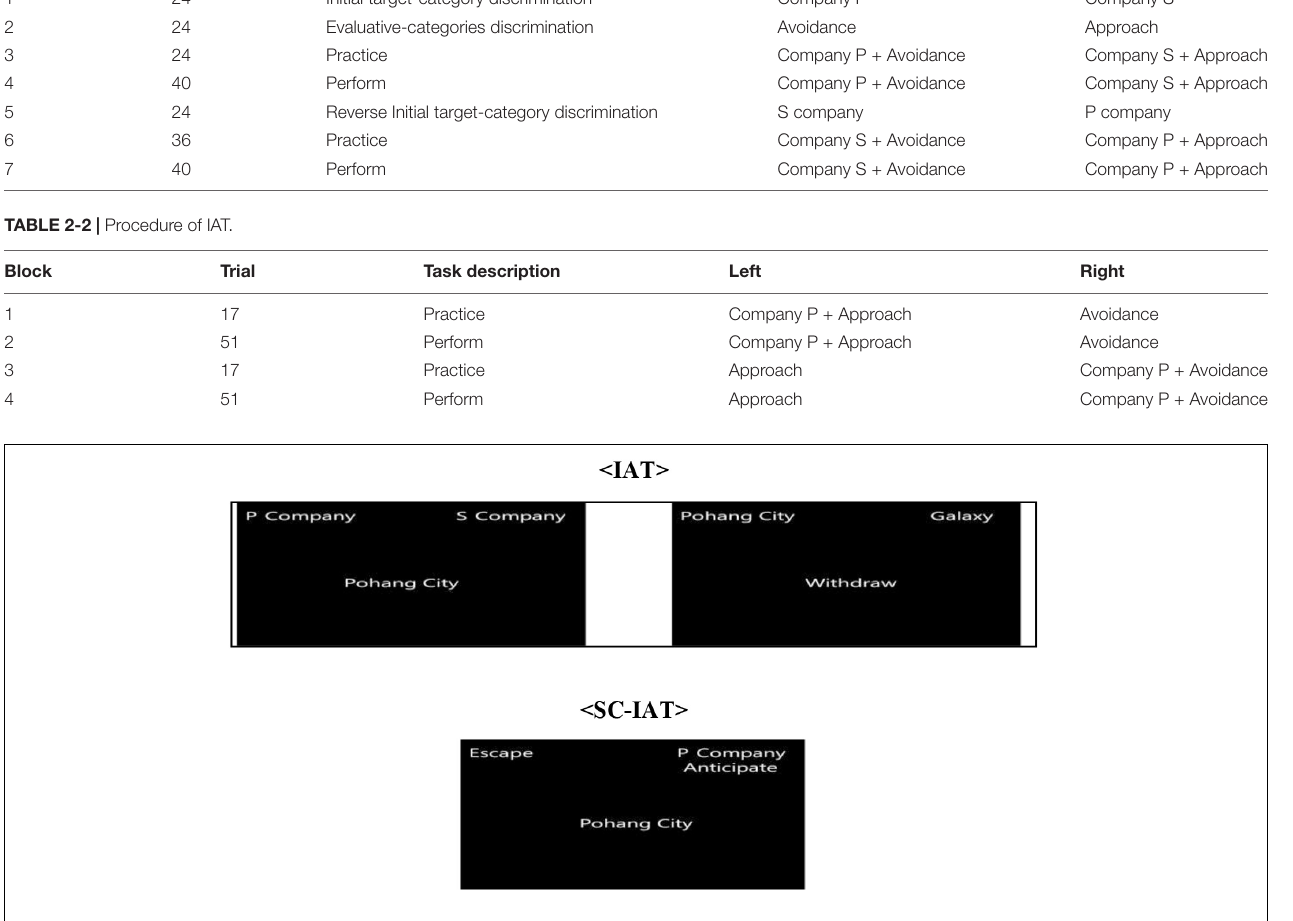
FIGURE 1 | Example of IAT and